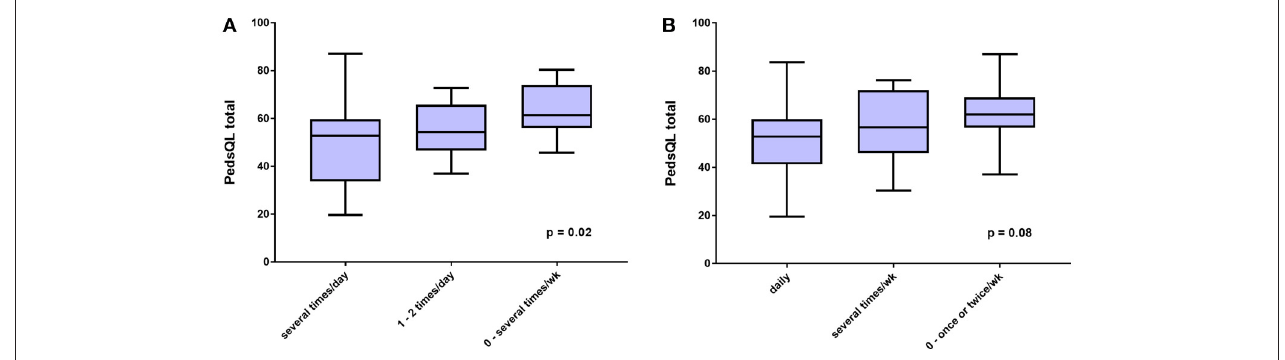
FIGURE 3 | HRQOL measured by PedsQL total score according to (A) , self-reported frequency of trouble thinking and concentrating, and (B) , self-reported frequency of lightheadedness, both in the preceding 2 weeks.